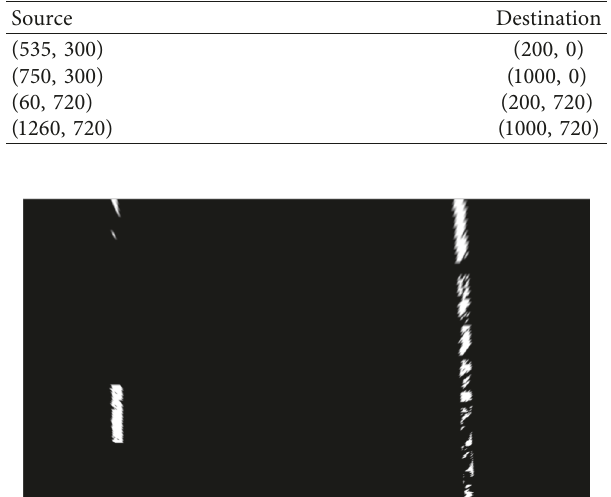
Figure 10: Lane mask after reversing perspective transformation.